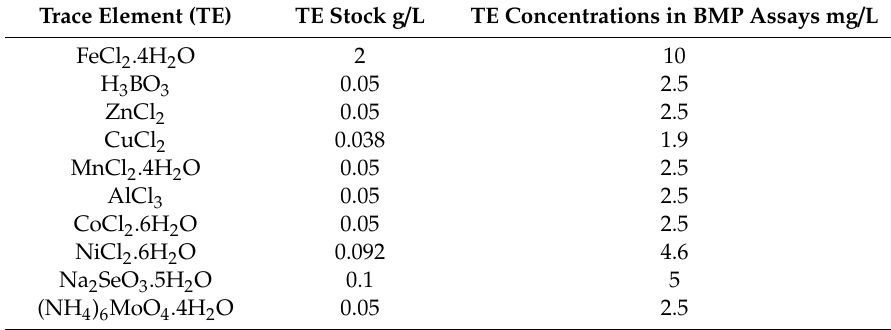
Table 1. Concentration of individual trace elements in stock solution and biomethane potential (BMP) assays.